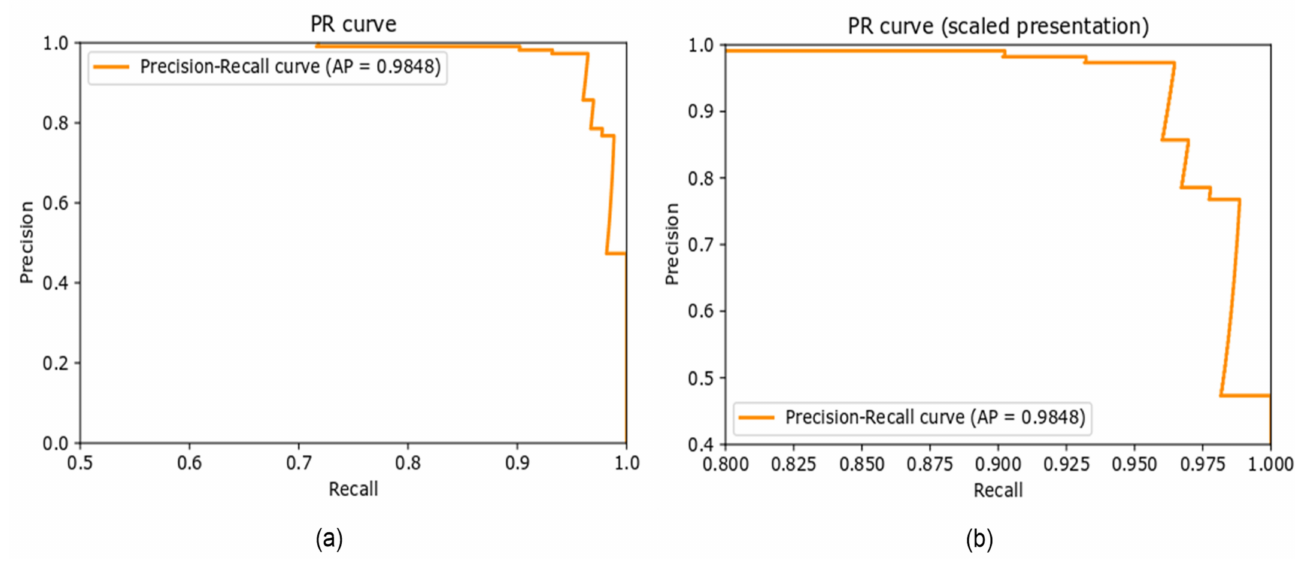
Figure 8. ( a ) Precision–recall curve, ( b ) scaled representation of Precision-recall curve.